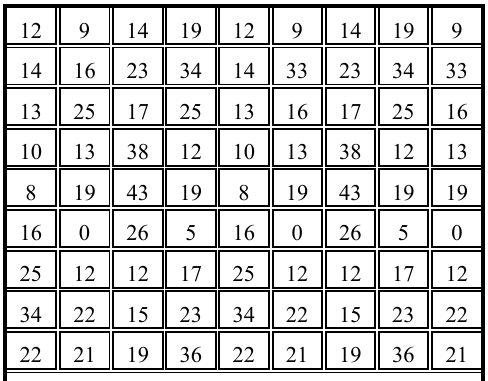
U tabeli 5 prikazan je primer